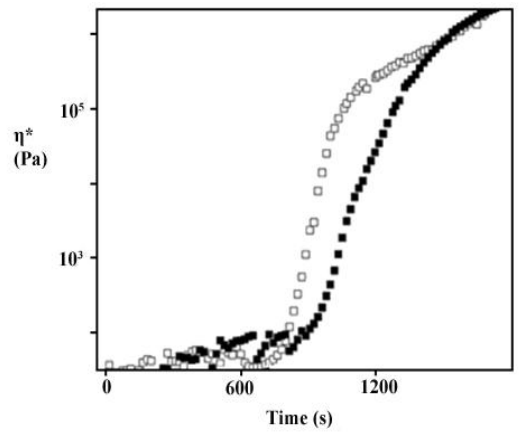
Figure 3. Zero shear viscosity vs. measuring time, s, for a 6.30 wt% LYSO dispersion at pH 2.5, (white symbols), and to the same dispersion with 0.03 wt% SWCNTs. Data are taken at T g . Gelation times are the salient points of the